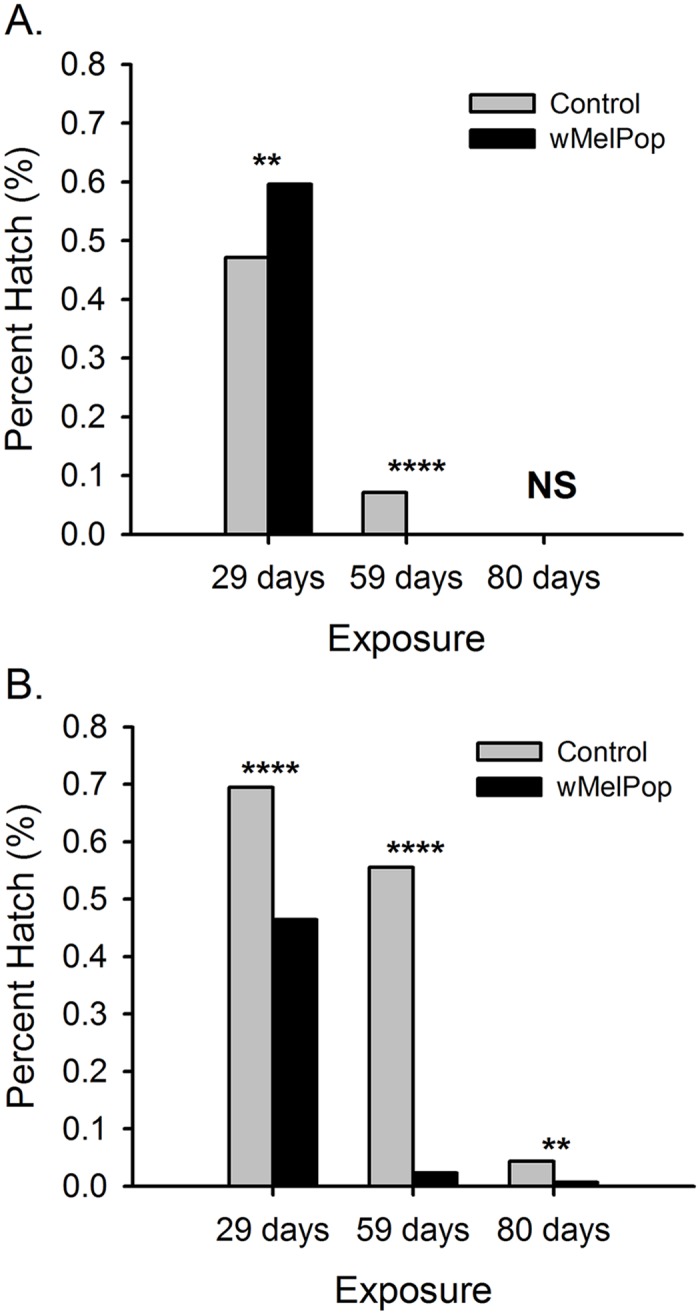
Egg survival (egg hatch) of wild and wMelPop infected Ae. aegypti eggs held outdoors in A. 70% and B. 99% shade from 18 Oct. 2013–6 Jan. 2014.** and **** denote P < 0.01 and P < 0.0001, respectively.